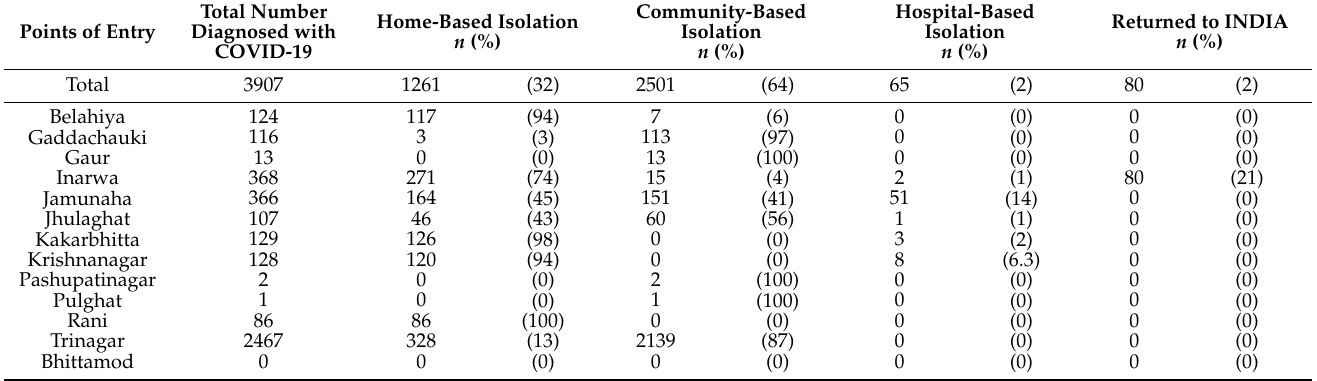
Table 3. Types of isolation for COVID-19 patients at each POE: 19 March 2021–15 July